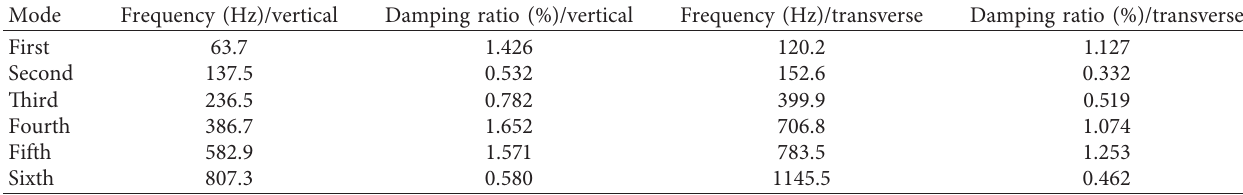
Table 3: Modal parameters of vertical and transverse modes.